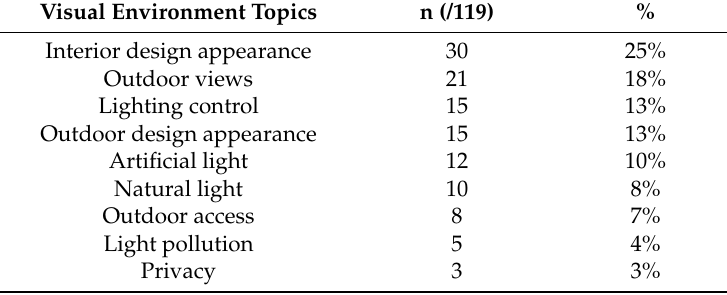
Table 5. Number and percentage of indicators grouped according to Visual Environment